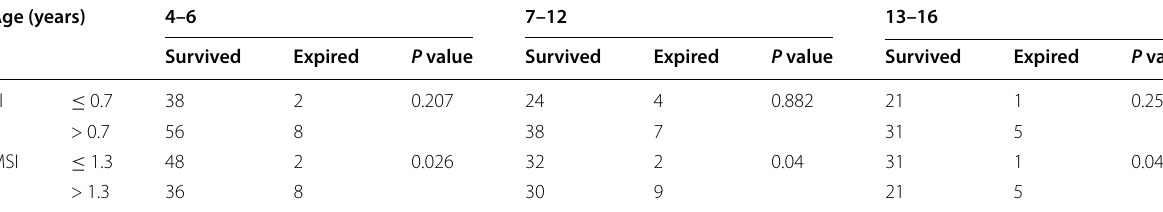
Table 4 Age wise distribution of SI and MSI with results of chi-square